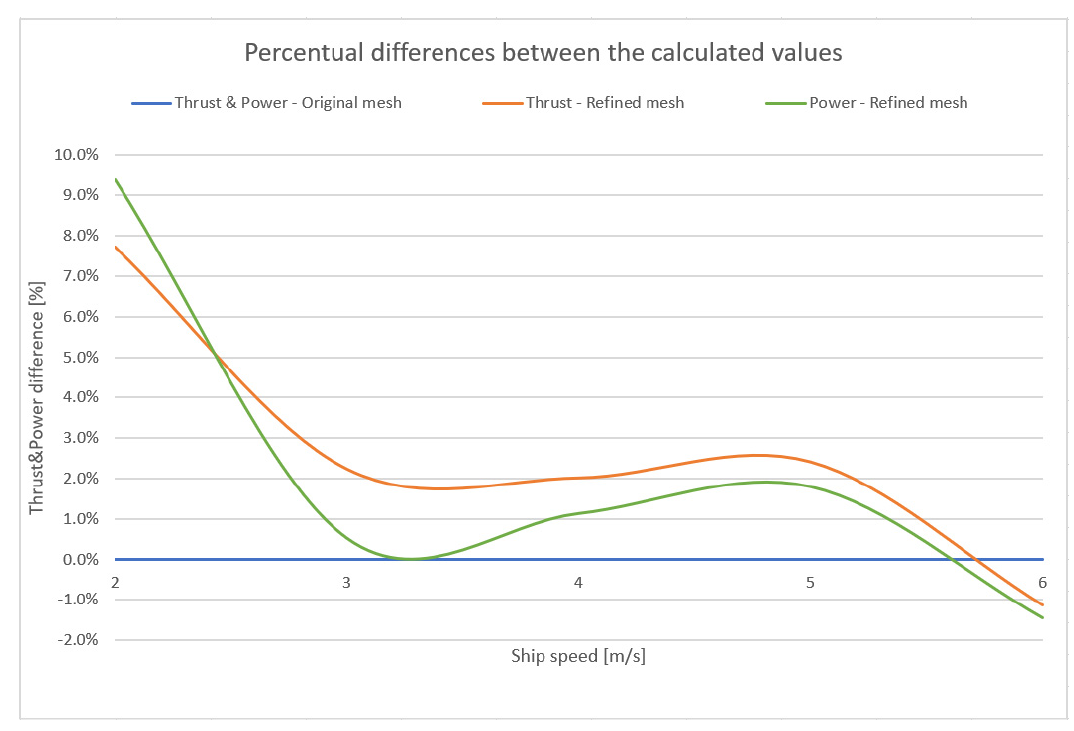
Figure 17. Percentual comparison of the original and the refined mesh results. Source: Authors.